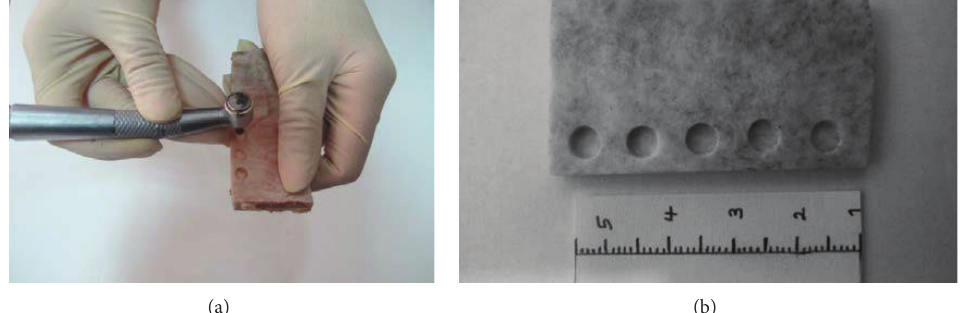
Figure 3: (a) The holes are made by wheel bur and high speed hand piece. (b) All the lesions are 5mm in diameter.